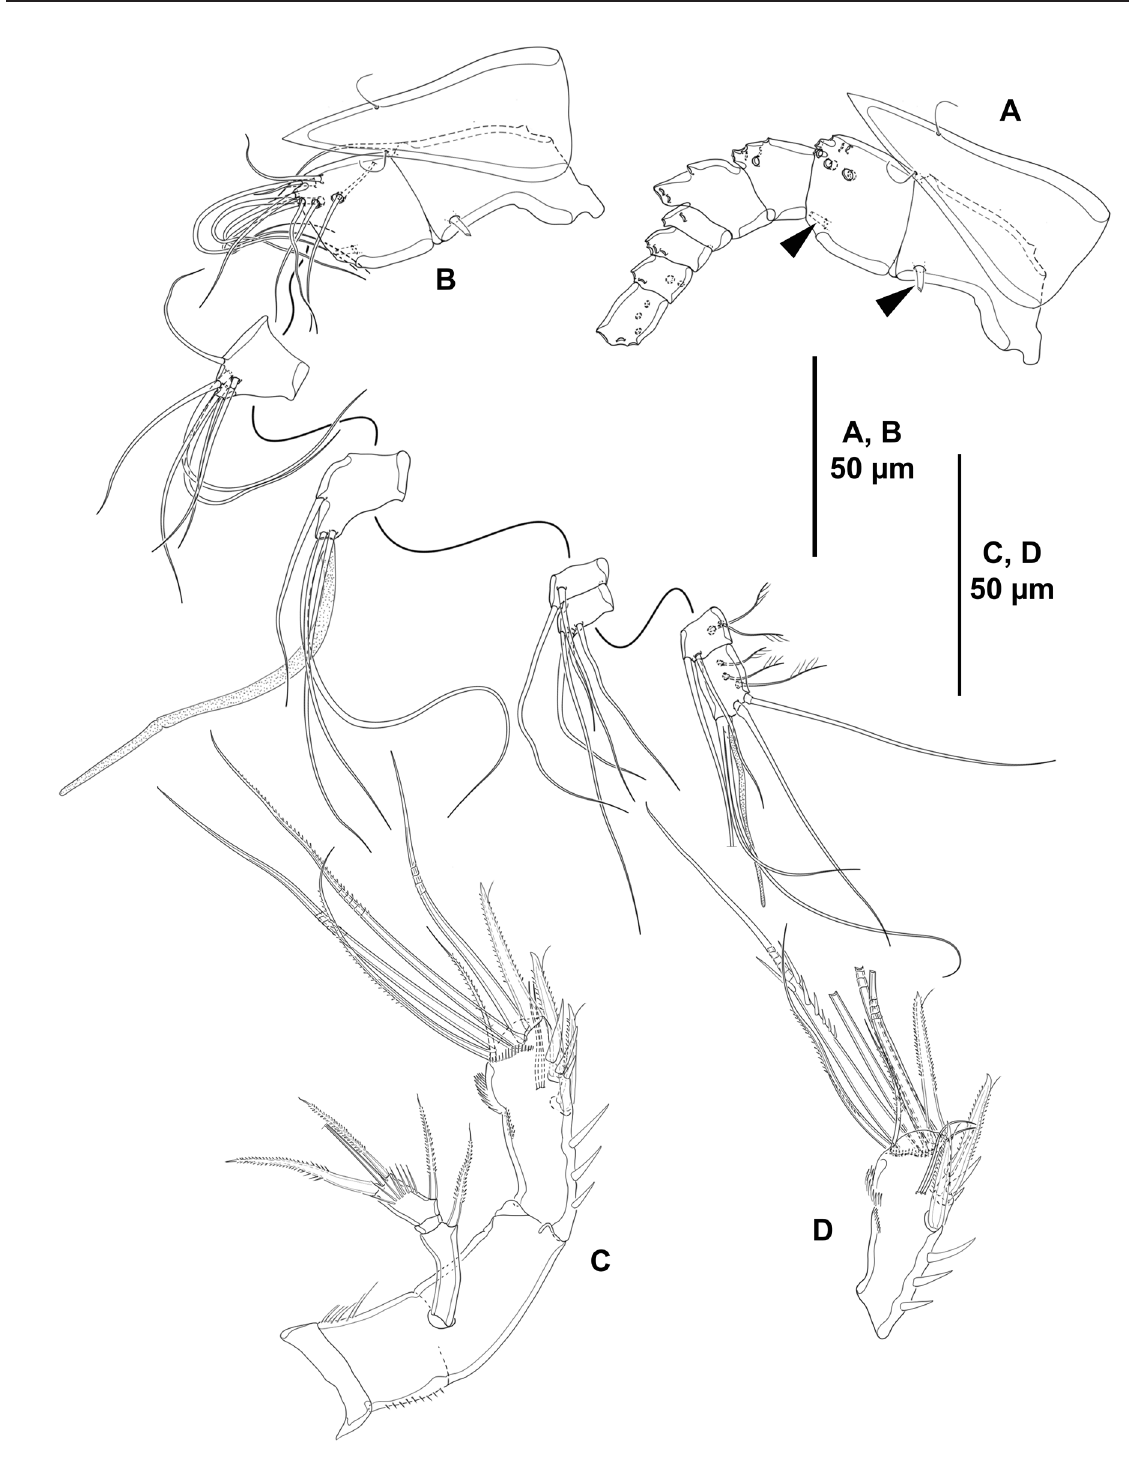
Fig. 3. Typhlamphiascus medici sp. nov., paratype, ♀ (ICML-EMUCOP-180119-41). A . Rostrum and antennule (armature omitted for simplicity; arrows indicate tube pores on first and second segments). B . Rostrum and antennule showing armature. C . Antenna with aberrant outermost geniculate seta (without spinular ornamentation), and with only two free geniculate setae. D . Free endopodal segment of another